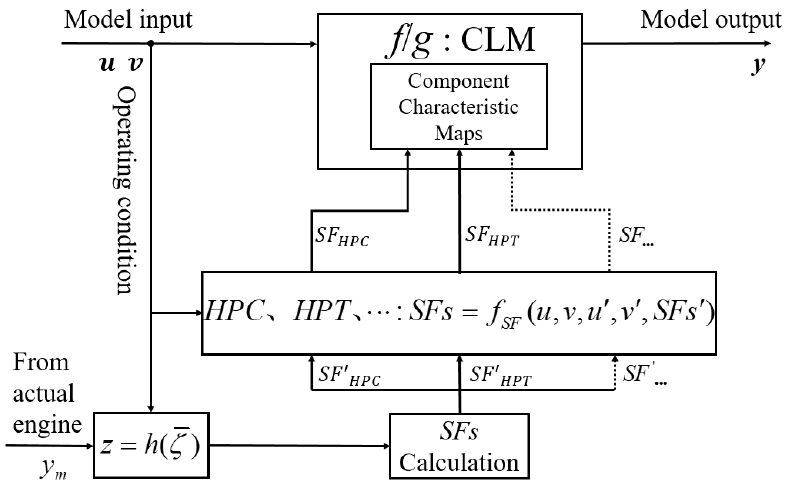
Figure 5. The framework of proposed onboard adaptive model.